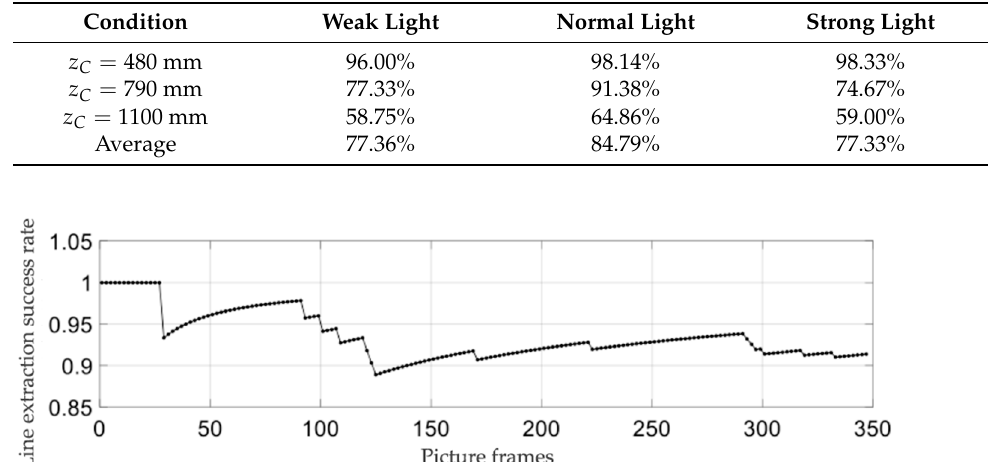
Table 1. Success rate of beacon straight − line feature extraction under different conditions.